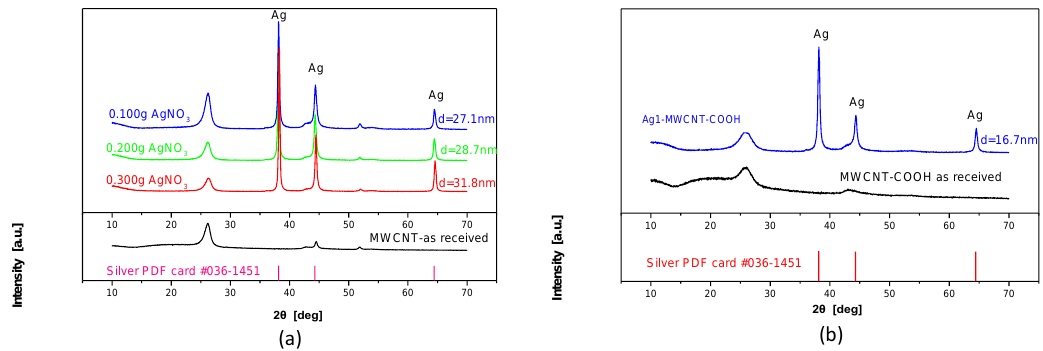
Table 2. Weight content of the Ag and average size of the Ag particles calculated from XRD measurements. Figure 1. X-ray diffraction patterns of ( a ) undecorated MWCNT and Ag1-MWCNT, Ag2-MWCNT and Ag3-MWCNT; ( b ) undecorated MWCNT – COOH and Ag1-MWCNT – COOH.